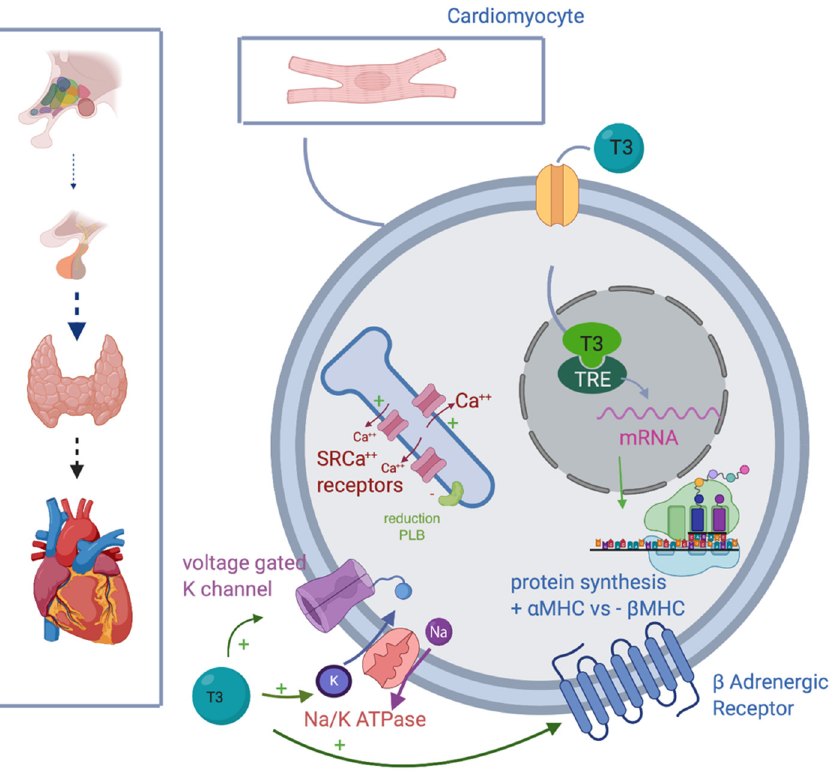
Figure 1. T3 improves myocytes and heart contractility, inducing intranuclear mRNA transcription, improving synthesis of fast α MHC, and reducing one of the slow β MHC; stimulating transmembrane expression of voltage-gated K channel, Na/K ATPase and β adrenergic receptors; upregulating SRCa ++ rec, while inhibiting PLB. Abbreviations: T3, triiodothyronine; mRNA, messenger RNA; α MHC, α myosin heavy chain; Na/K ATPase, sodium-potassium adenosine triphosphatase; SRCa ++ receptors, sarcoendoplasmic reticulum (SR) Ca(2+) receptors; PLB, phospholambane; TRE, thyroid hormones response element; β MHC, β myosin heavy